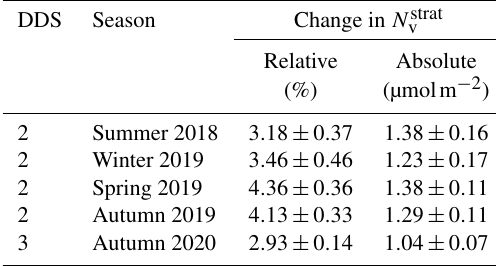
Table 4. Relative and absolute differences in the stratospheric VCD between the DDS and OFFL data averaged over the VCD periods (cf. Table 1) for the ground pixels with valid SCD retrieval results in the 30 ◦ tropical latitude